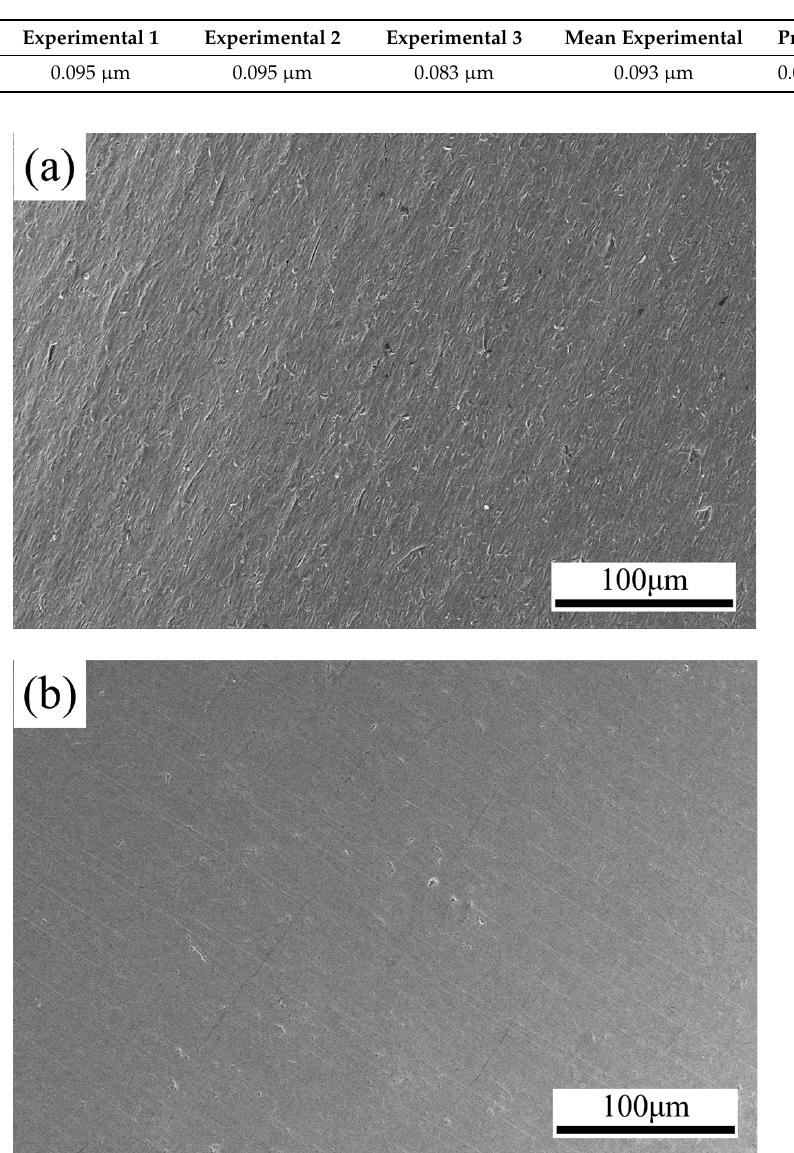
Figure 11. SEM surface morphology of the inner wall of the Ni-Ti alloy vascular stent tubing ( a ) before processing (0.356 µ m); ( b ) after processing (0.083 µ